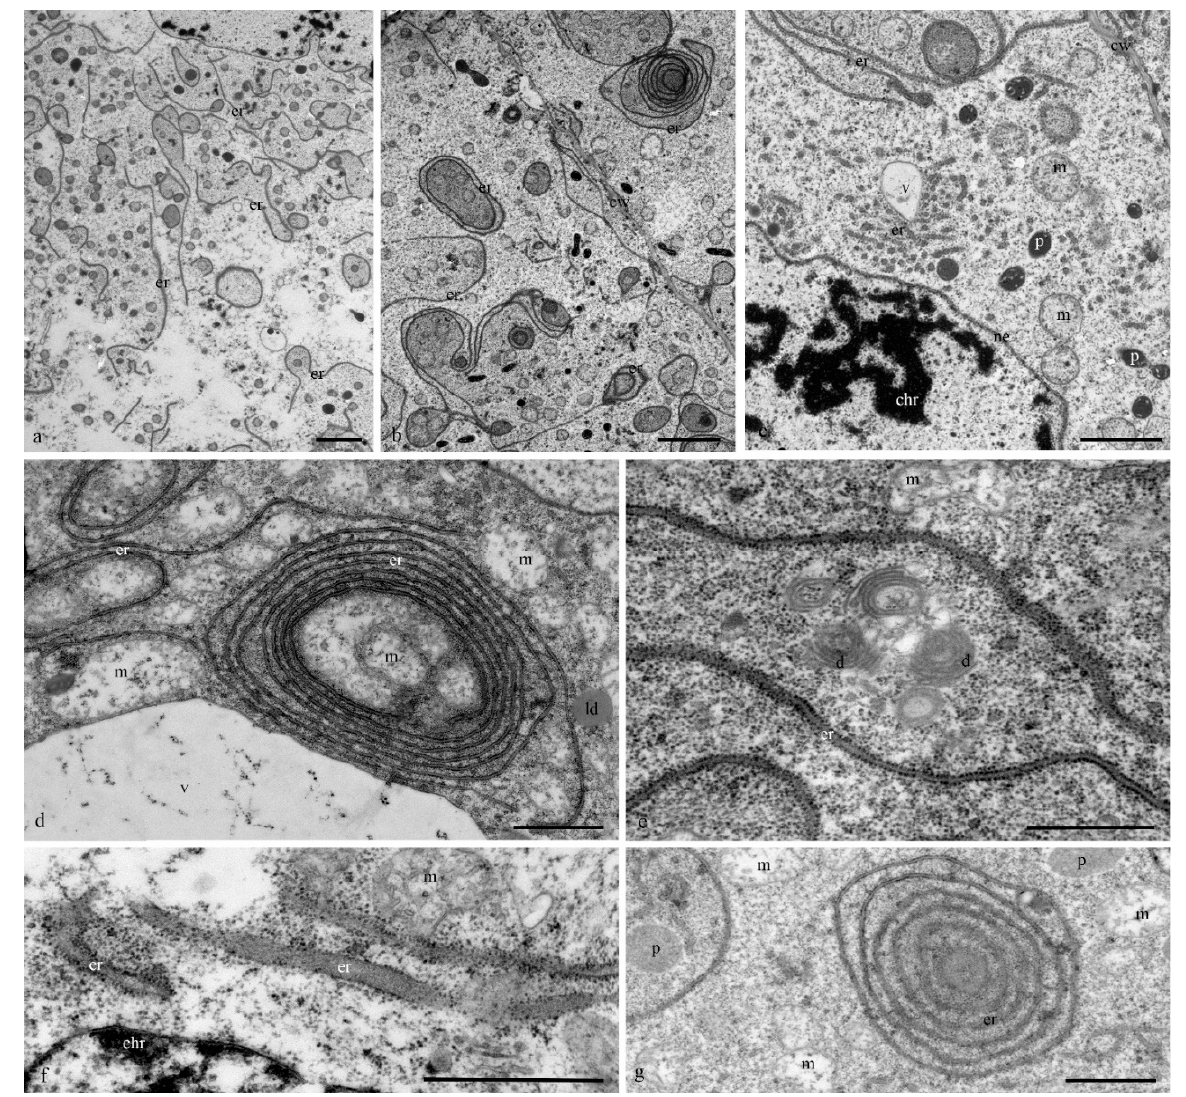
Figure 7. Ultrastructure of the granular reticulum of the antipodal cytoplasm of the wheat embryo sac cells. A network of extended flat cisternae ( a – c ) and tubes ( b ) of granular reticulum at an early stage of differentiation. Concentric circles ( d , g ) and expanded cisternae of the granular reticulum during PCD. Ne –nuclear envelope; chr—polytene chromosomes; er—granular reticulum; m—mitochondria; p—plastids; d—dictyosomes; v—vacuoles; ld—lipid droplets; cw—cell wall. Scale: ( a – c )—10 µm; ( d – g )—5 µm.